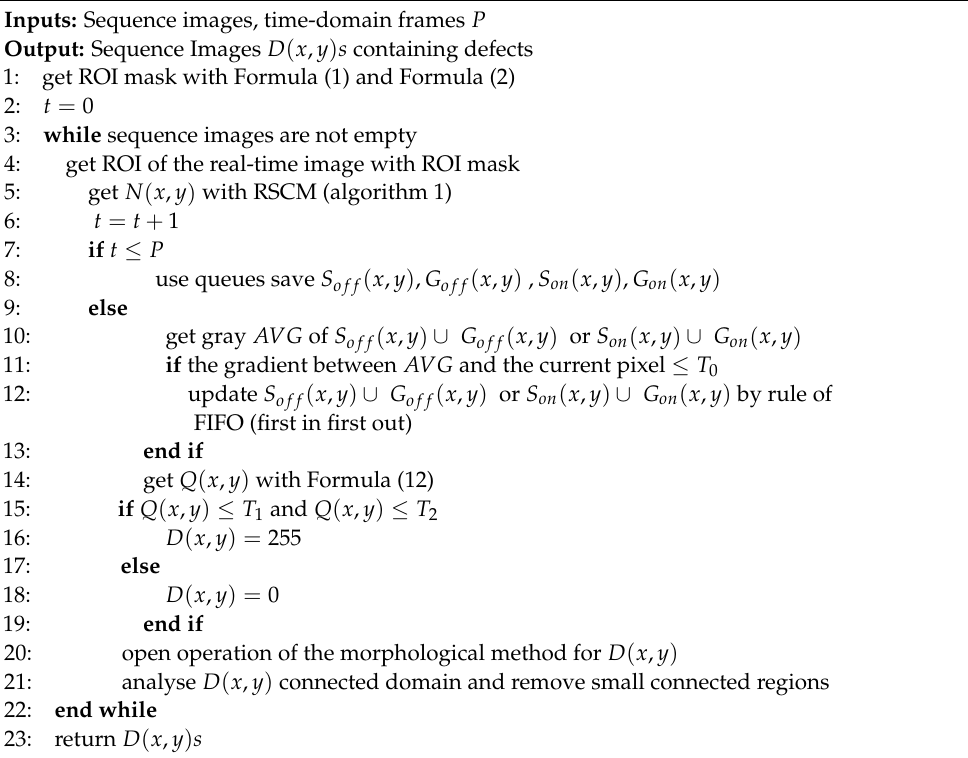
Algorithm 2. Steel wire rope surface defect detection method based on segmentation template and spatiotemporal gray sample